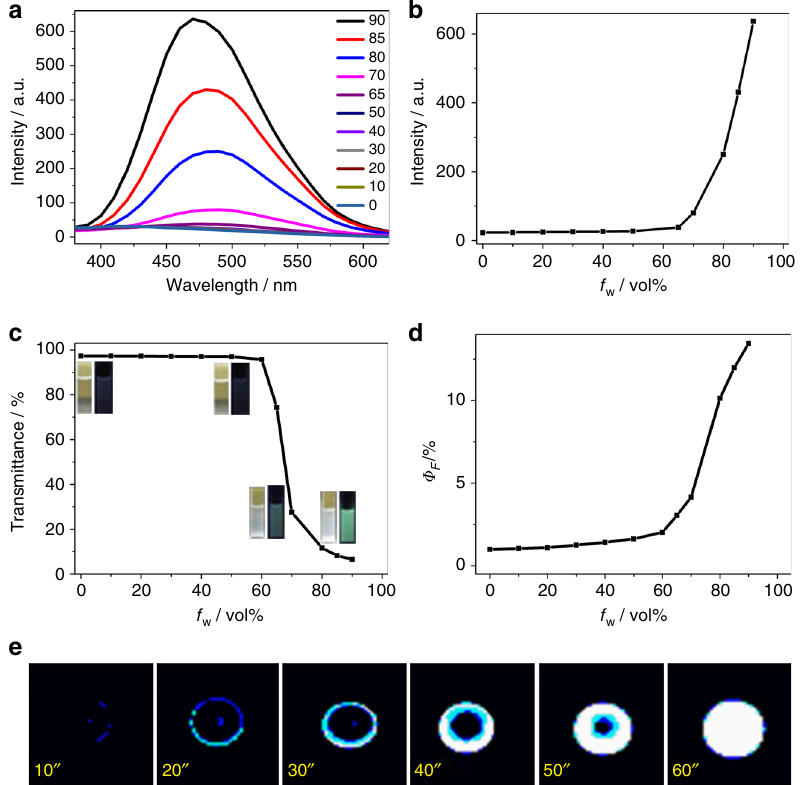
Fig. 3 AIE properties of PTPM-1. a Emission spectra (excited @346 nm), b emission intensities (excited @346 nm), c transmittance @500 nm wavelength and digital photos (under sunlight and irradiation with UV lamp @365 nm), and d fl uorescent quantum yields ( Φ F ) of PTPM-1 (0.1 mg/mL) in water/THF mixtures with different water volume fractions ( f W ); e digital photos of one drop of PTPM-1 solution (10 mg/mL in THF) on thin-layer chromatography plate with different evaporation timescale at room temperature (under irradiation with UV lamp @365